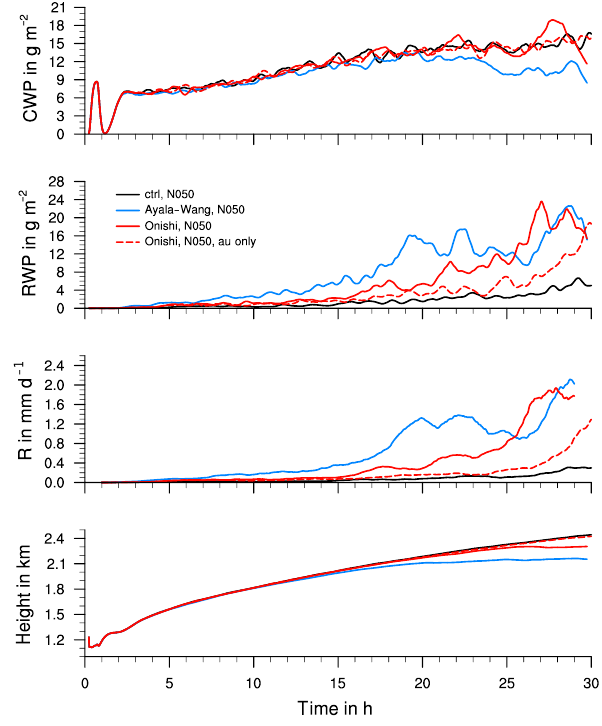
Figure 5. Time series of the cloud liquid water path, rainwater path, the surface rain rate, and the inversion height for four simulations using the three different collection kernels. The simulation marked “au only” applies the turbulent enhancement only to autoconver- sion, ignoring the effect on accretion. We have applied a running av- erage to all time series with an averaging window of 120min for the surface rain rate and 30min for RWP, CWP, and inversion